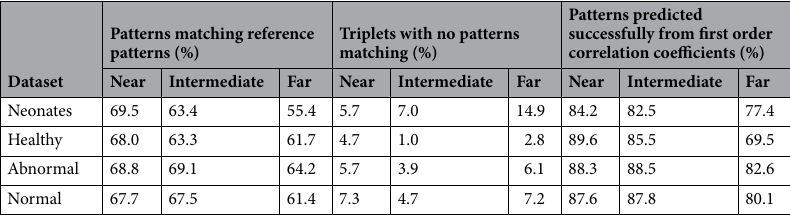
Table 1. Overall statistics for data sets 2–4 across all the three sets of triplets.